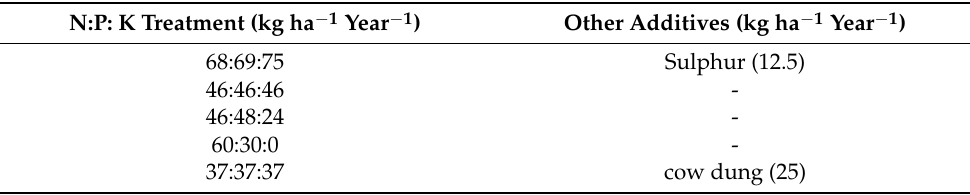
Table 2. Different J. curcas fertilization treatments from the literature. This information is adapted from Alherbawi et al.